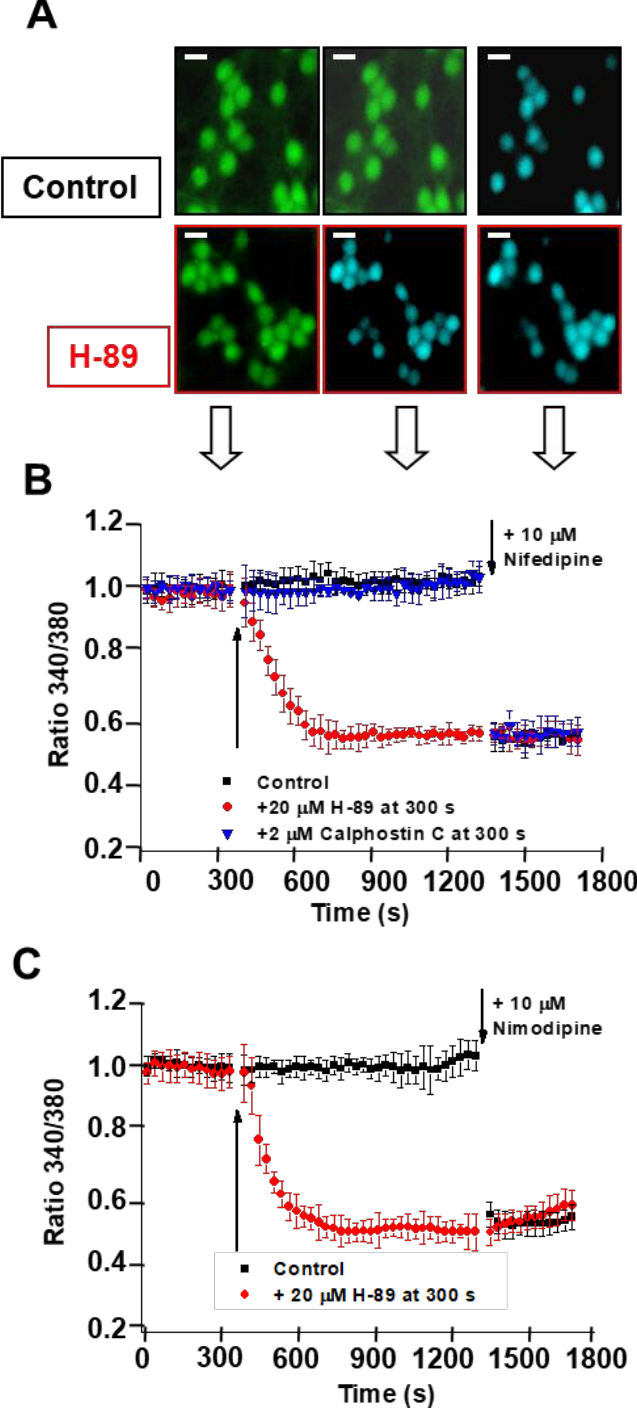
Figure 5. H-89 decreases CGN steady-state [Ca 2+ ] i to values obtained upon the blockade of LTCCs by nifedipine and nimodipine, while calphostin C has no effect. Mature CGNs in culture were loaded with Fura-2, as indicated in the Materials and Methods section, and then changed to MLocke’s K25 buffer (37 °C) and treated with the indicated protein kinase inhibitors. ( A ) Representative pseudocolor images of the same fields of selected CGN plates before (left-most column of images) and after 15 min incubation (middle column of images) with 20 µM of the PKA inhibitor (H-89) or in the absence of inhibitor (control) and 2 min after the addition of 10 µM nifedipine post-H-89 (images in the right- most column). Pseudocolor scale for 340/380 ratio values: light blue, 0.5 – 0.6; green, 1.0 – 1.1. Scale bar = 10 µm. The white-filled arrows pointing toward Panel B indicate the approximate times at which these images were captured. ( B , C ) Time dependence of population averages of the 340/380 ratio in neuronal somas before and after the addition of the indicated protein kinase inhibitors after 350 s (at the point indicated by the first arrow). The kinetic analysis of the 340/380 ratio of the somas of CGNs was done for controls (vehicle DMSO addition, solid black squares) and for the addition of 20 µM H- 89 (red solid circles) and 2 µM calphostin C (blue down-triangles), inhibitors of PKA and PKC, respectively. Each inhibitor was added to a different culture plate. At approximately 1350 s (at the point indicated by the second arrow), 10 µM nifedipine ( B ) or 10 µM nimodipine ( C ) was added to the culture plates in all conditions. Data acquisition and analysis were done after the selection of neuronal somas using the region of interest (ROI) tool of the HCImage software, as indicated in the Materials and Methods section, with exposure times lower than 0.4 s at time intervals of 30 s. The 340/380 ratio values shown are the average ± S.E. of experiments done with three different preparations of CGNs (n > 300 neuronal somas of fields taken from six plates for each experimental condition). 2.5. Inhibition of PKA Alters the LTCC Response to Partial Depolarization of the Plasma Membrane in CGNs In MLocke ’s with 5 mM KCl, fluorescence imaging of CGNs loaded with Fura-2 yields a low steady 340/380 ratio in the neuronal somas of 0.50 ± 0.05, i.e., [Ca 2+ ] i ~40 – 50 nM (Figure 6A,B). The same 340/380 ratio readings were obtained in this medium in the presence or absence of H-89 (PKA inhibitor) added to the plate 10 min before starting the measurements of cytosolic calcium concentration (Figure 6A,B). However, H-89 largely impairs the kinetics of the [Ca 2+ ] i response to the addition of 20 mM KCl to the extracellular medium, which increases the extracellular KCl up to 25 mM. In the controls for CGNs loaded with Fura-2, the addition of 20 mM KCl elicits biphasic kinetics with a strong and fast rise in the 340/380 ratio until reaching values higher than 1.0 — between 1.2 and 1.5 for most neuronal somas in the plates — followed by slower kinetics for the decay in the 340/380 ratio (t½ ≤ 2 min) until reaching values of approximately 0.95 ± 0.05 (Figure 6A,B), i.e., [Ca 2+ ] i ~150 ± 30 nM, which is within the range obtained for the somas of CGNs loaded with Fura-2 several minutes after changing the cells to MLocke ’s K25 [34]. The pre-incubation of CGNs with H-89 for only 15 min largely attenuates the rise in the 340/380 ratio after the addition of 20 mM KCl to the extracellular